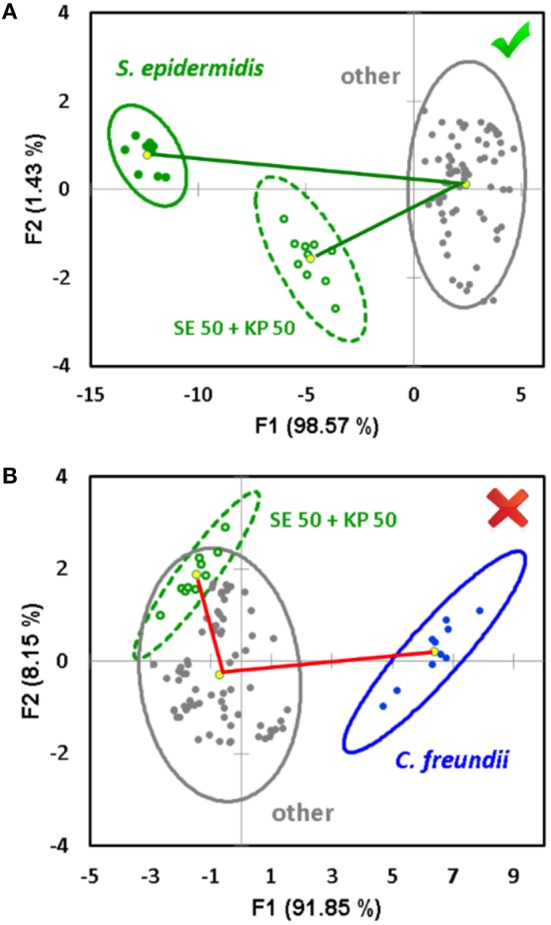
Example of a positive (A) and negative (B) decision regarding a potential component of an unknown mixture in the “one against the rest” analysis. The decision is made based on the overlap between the 95% confidence ellipses of the mixture and the complex of “other” bacteria, and the angle between the vectors connecting the ellipse centroid of the “other” aggregate group and the signal of the component under question, respectively.